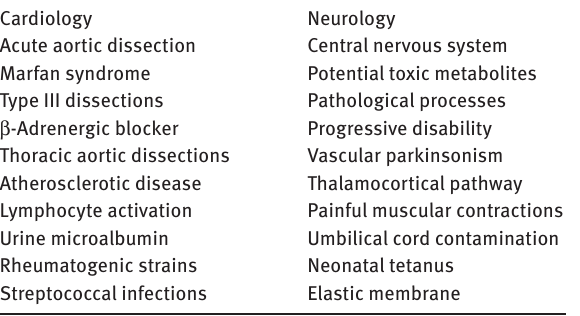
Table 1: Some of the Concepts/Medical Phrases Extracted for Cardiology and Neurology Categories.